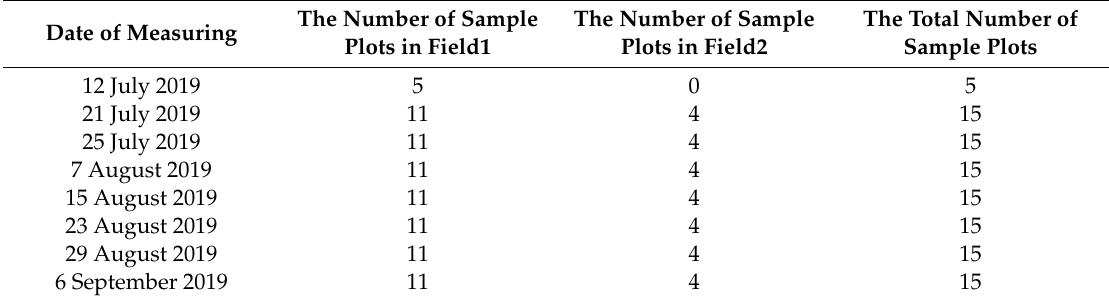
Figure 1. ( a ) Location of the field experimental site. ( b ) The spatial distribution of sample plots. Table 1. Dates of measuring and the number of sample plots.